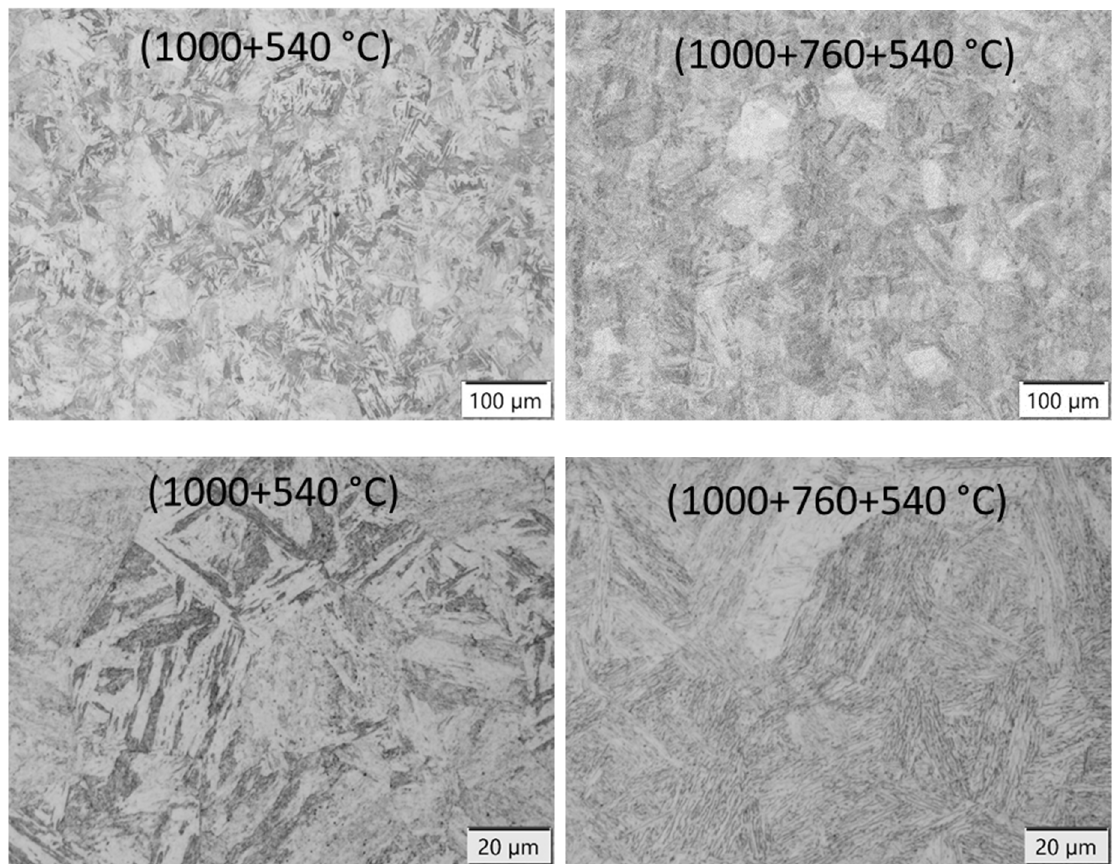
Figure 6. Optical micrographs of the Q + T (1000+540 °C) and Q + I + T (1000 + 760 + 540 °C) samples.